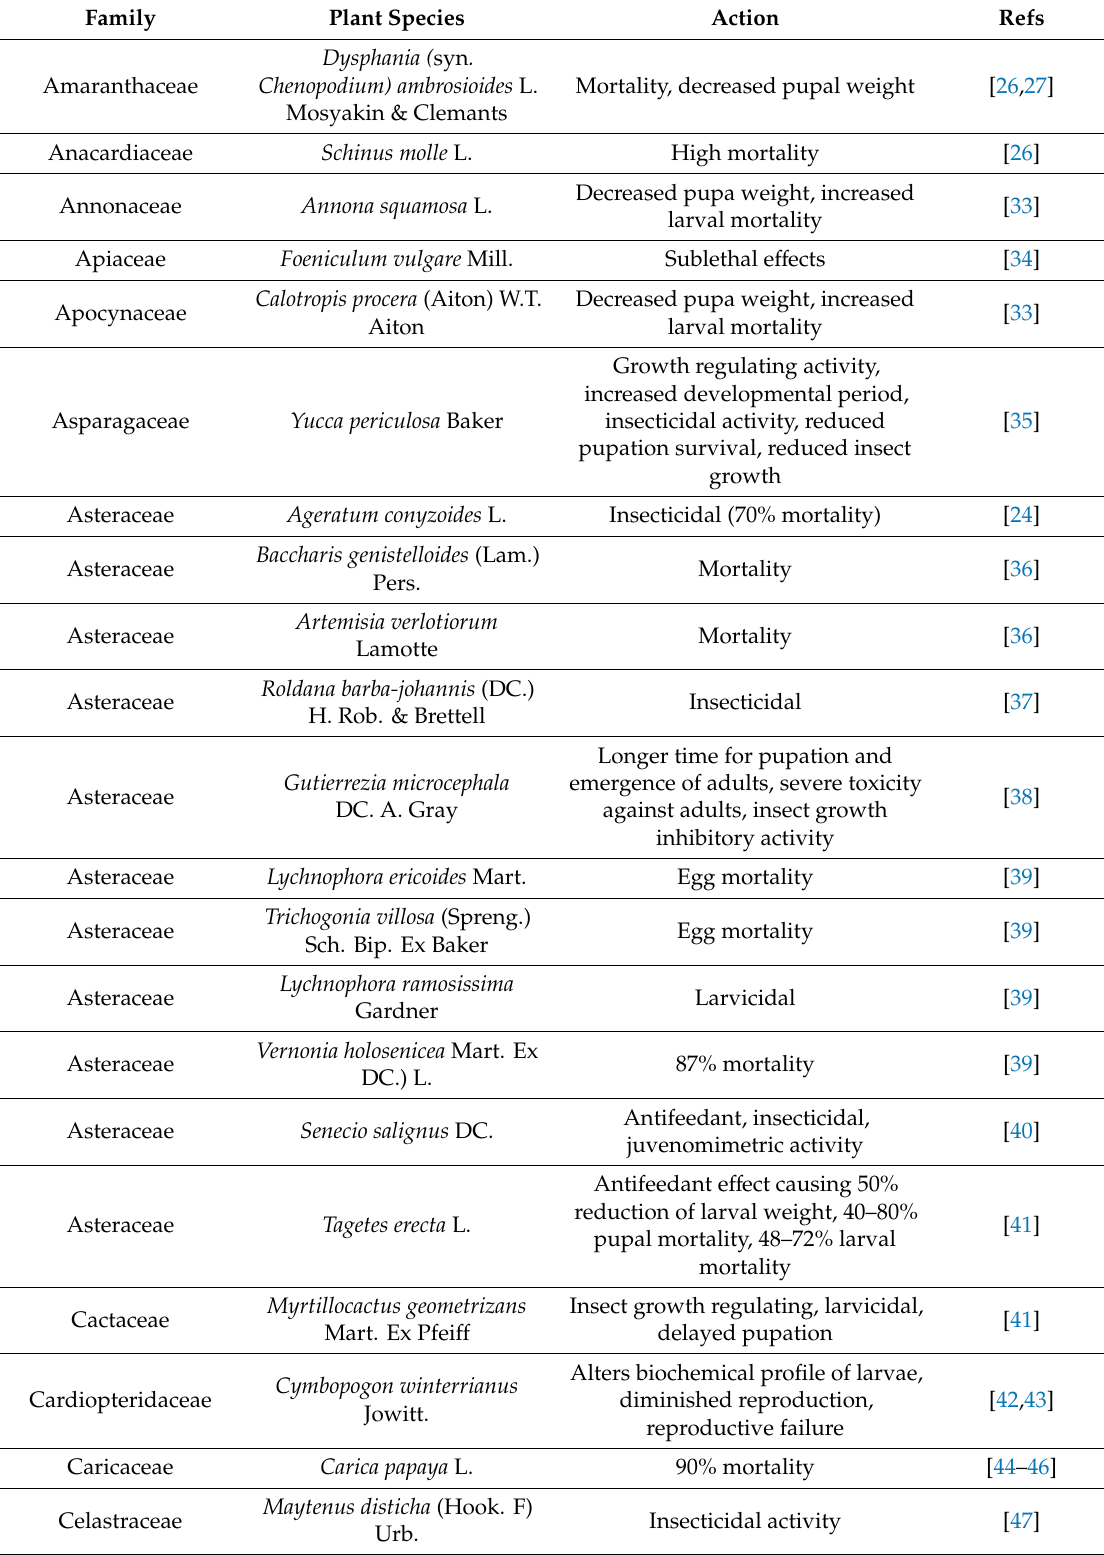
Table 1. Plant species that have been evaluated for their activity against Fall Armyworm (FAW) and potential for use in its